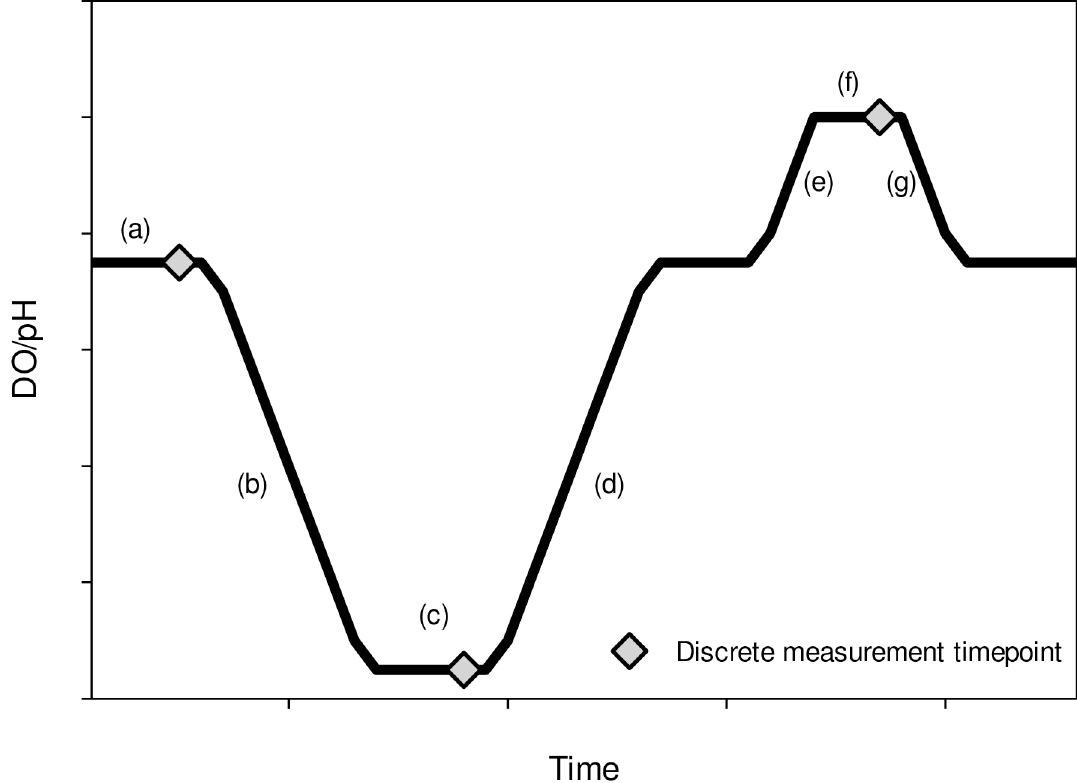
Fig 1. Idealized diel cycle for laboratory experiments after Burrell et al. (2015). Cycles are designated as: (a) ‘ normoxia ’ , (b) ‘ down-to-low ’ , simulated late evening, (c) ‘ low plateau ’– which can refer to low DO, low pH or both, simulated pre- dawn, (d) ‘ up-to-normoxia ’ , simulated dawn, (e) ‘ up-to-supersat ’ , simulated early afternoon, (f) ‘ supersat plateau ’ , simulated midafternoon, (g) ‘ down-to-normoxia ’ , simulated late afternoon. Diamond markers indicate time points where discrete measurements of DO and pH were taken in each